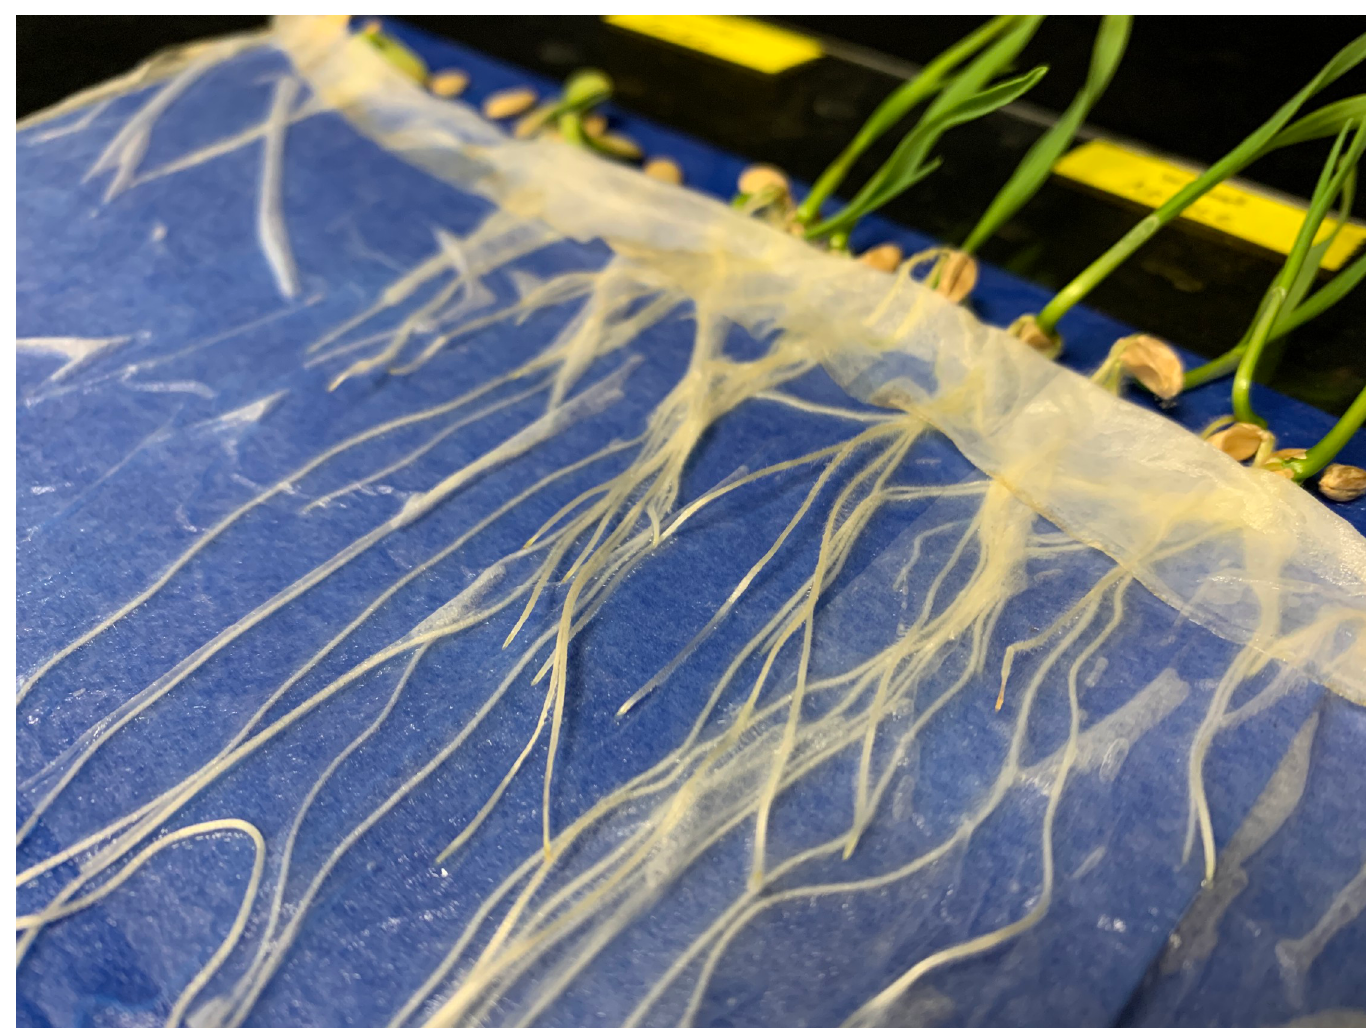
Fig 3. Example of the growth of wheat roots through the thin absorbent paper. It is difficult to separate the roots from the paper when this occurs. In this case, an additional piece of germination paper is recommended in place of the thin absorbent paper.